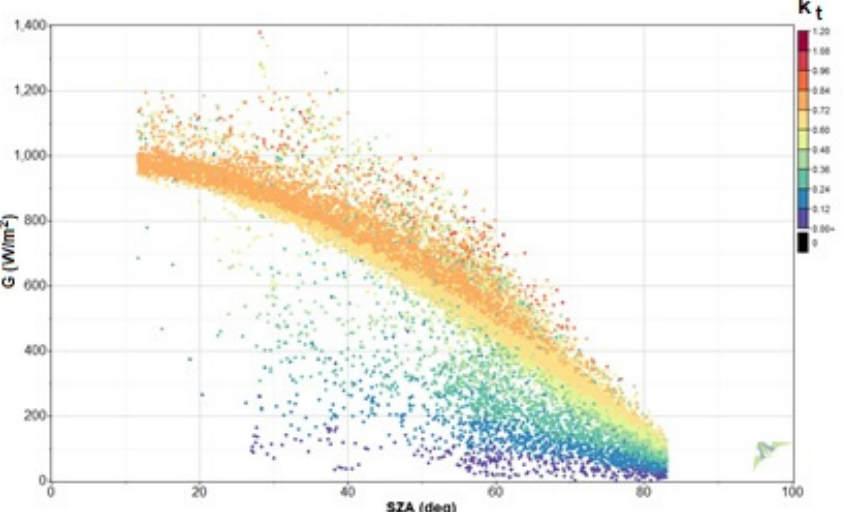
Figure 15. Solar global irradiances as a function of solar zenith angle (SZA) and clearness index ( k t ).